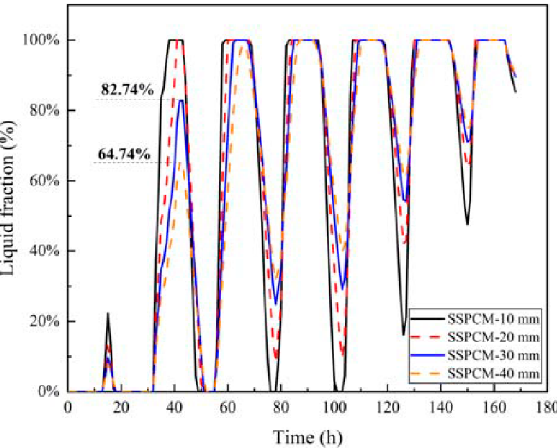
Figure 12. The liquid fraction of the SSPCM layer with different SSPCM thicknesses.